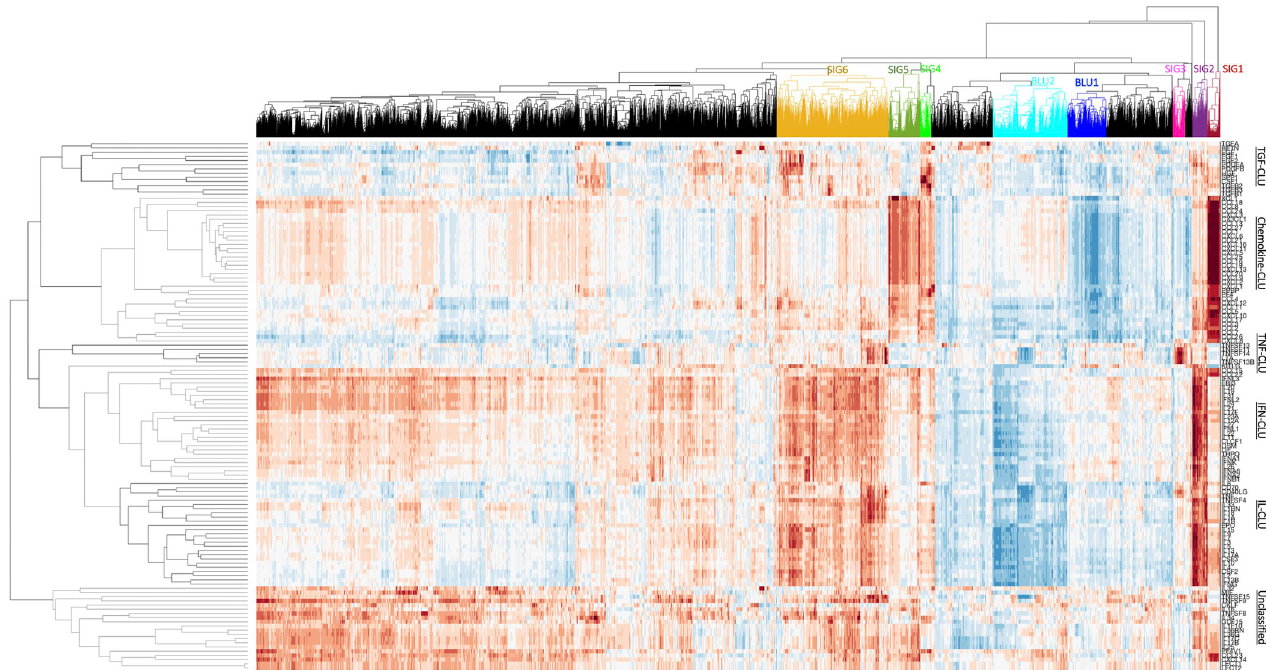
Fig 4. The 126 cytokines form six clusters based on their Association Scores with the 14,581 non-cytokine genes. The six clusters are named after their most enriched types of cytokines: TGF-CLU (growth factors), Chemokine-CLU (chemokines), TNF-CLU (TNFs), IFN-CLU (interferons), IL-CLU (interleukins), and Unclassified-CLU. Based on the dendrogram of the hierarchical cluster tree, we identified six gene sets (SIG1-SIG6) that associate with the six individual clusters and two gene sets (BLU1, BLU2) that do not interact with the three major clusters (Chemokine-CLU, IFU-CLU, IL-CLU). Details of cytokines and signatures are in Tables 1–4.